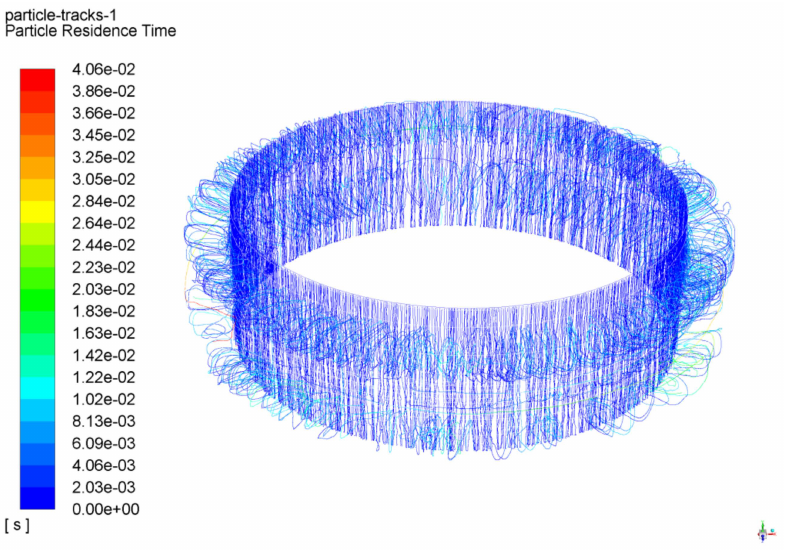
Figure 11. The retention time of debris